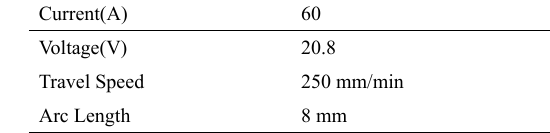
Table 3. Weld input parameters.